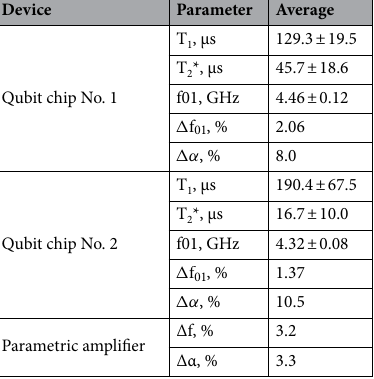
Table 1. Properties of the fabricated